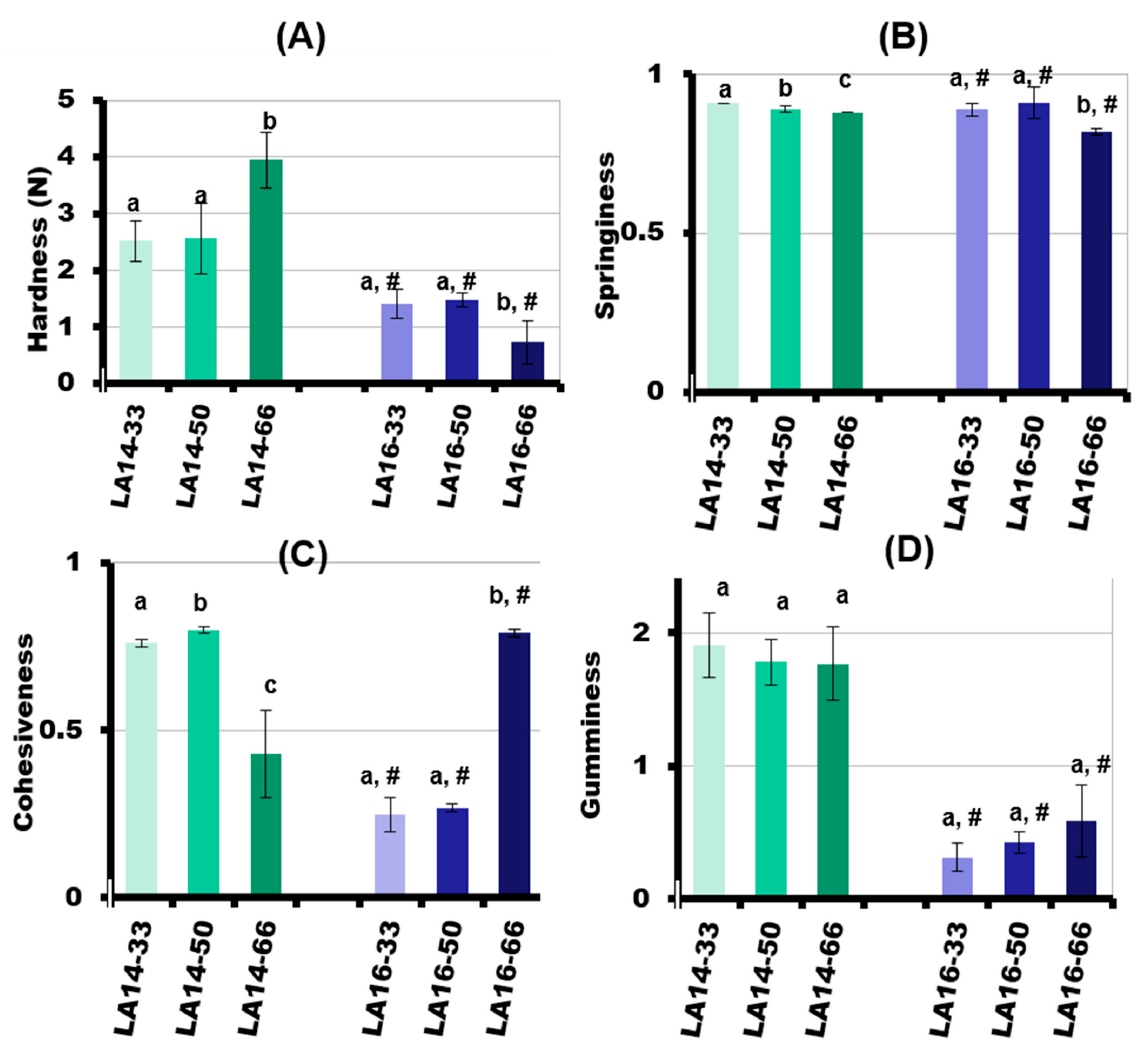
Figure 6. Mechanical properties of the 3D ‐ printed gels. Hardness ( A ), springiness ( B ), cohesiveness ( C ), and gumminess ( D ) are given as the mean ± SD ( n = 8). Different lowercase letters indicate significant differences ( p < 0.05) among means for different callus concentrations; #— p < 0.05 vs.